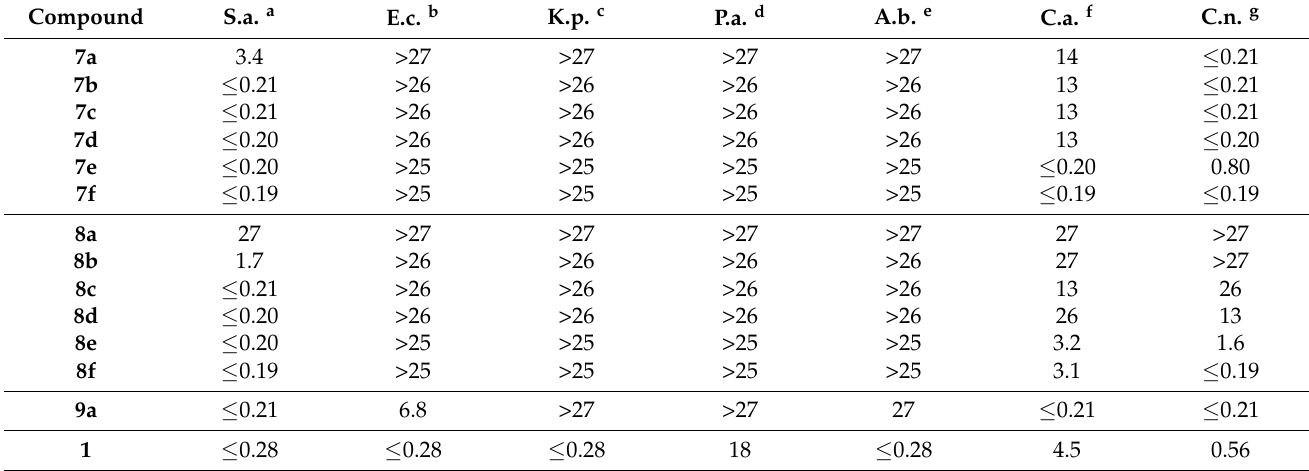
Figure 4. HDCA ( 7a – f ), UDCA ( 8a – f ) and CDCA ( 9a ) analogues. Table 1. Antimicrobial (MIC, µ M) activities 1 of compounds 7 – 9 and squalamine ( 1